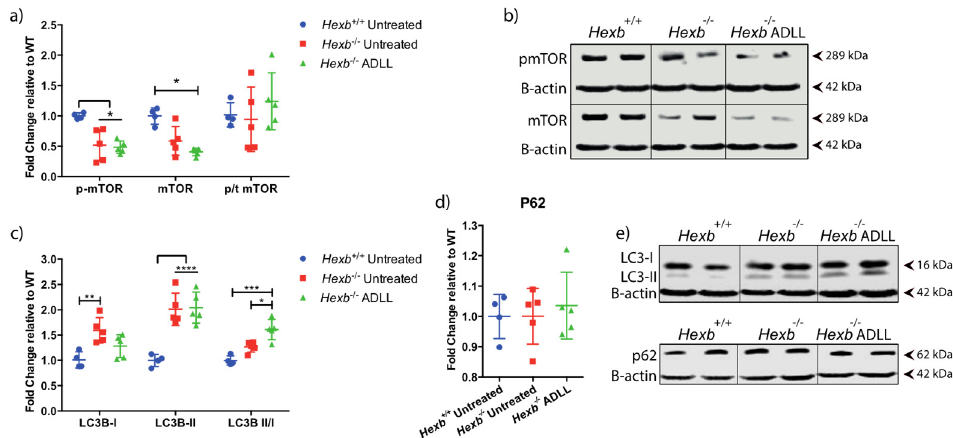
Figure 2. E ff ect of acetyl- DL -leucine on autophagy in the cerebellum of 12-week-old Hexb - / - mice. Wild-type untreated ( Hexb +/+ ), Sandho ff untreated ( Hexb - / - UT), ADLL ( Hexb - / - ADLL). In total, four animals for Hexb +/+ , and five animals for Hexb - / - UT and Hexb - / - ADLL. Proteins of interests were probed by Western blot and normalized to β actin. Fluorescence values were obtained with Fiji software and calculated relative to Hexb +/+ . ( a ) mTOR, p-mTOR expressions and mTOR p :T rations, mean ± SD * p < 0.05, (two-way ANOVA). ( b ) Western blot images of p -mTOR and mTOR proteins and their β -actin loading controls. ( c ) LC3-I, LC3-II expressions, and ratio of LC3-II versus LC3-I, mean ± SD, * p = 0.0483, ** p = 0.0011, *** p = 0.0006, **** p < 0.0001 (two-way ANOVA). ( d ) p62 levels, mean ± SD (one-way ANOVA). ( e ) Western blot images of LC3s and p62 with their β -actin loading controls. Samples on the same blots were cut (inserted lines) for appropriate visual